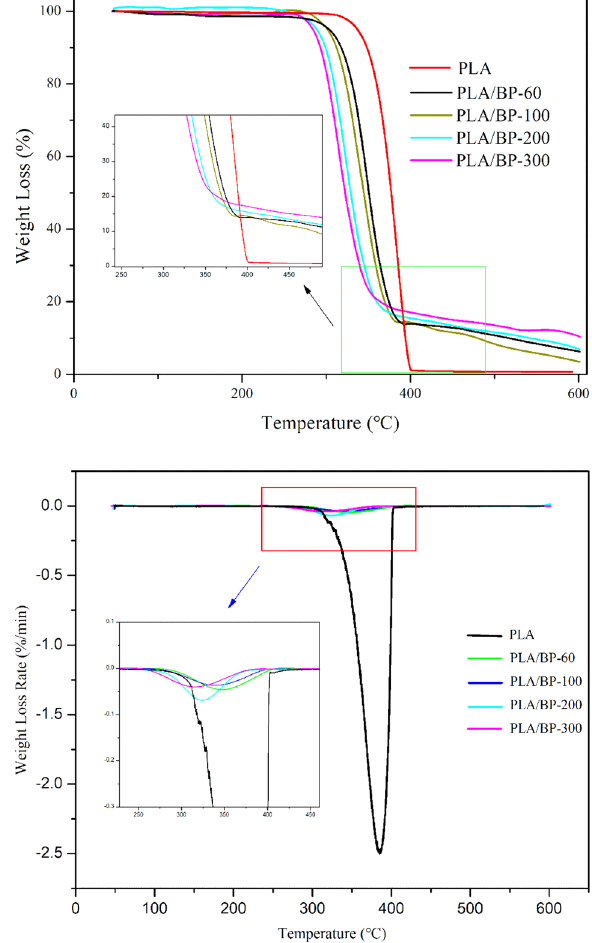
Figure 7: TG and DTG curves of